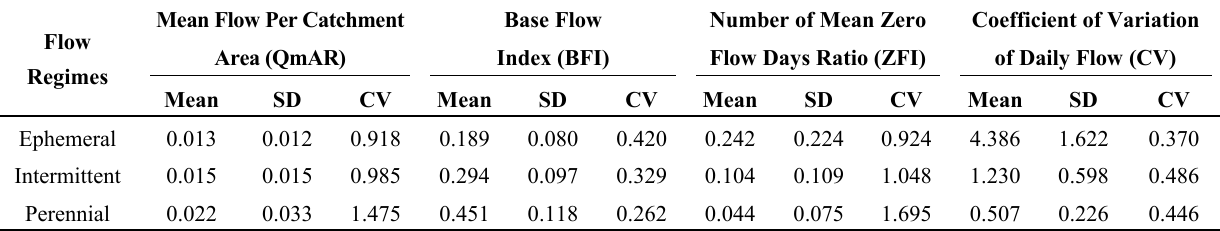
Table 3. The mean, standard deviation (SD) and coefficient of variation (CV) of variables of flow regimes.